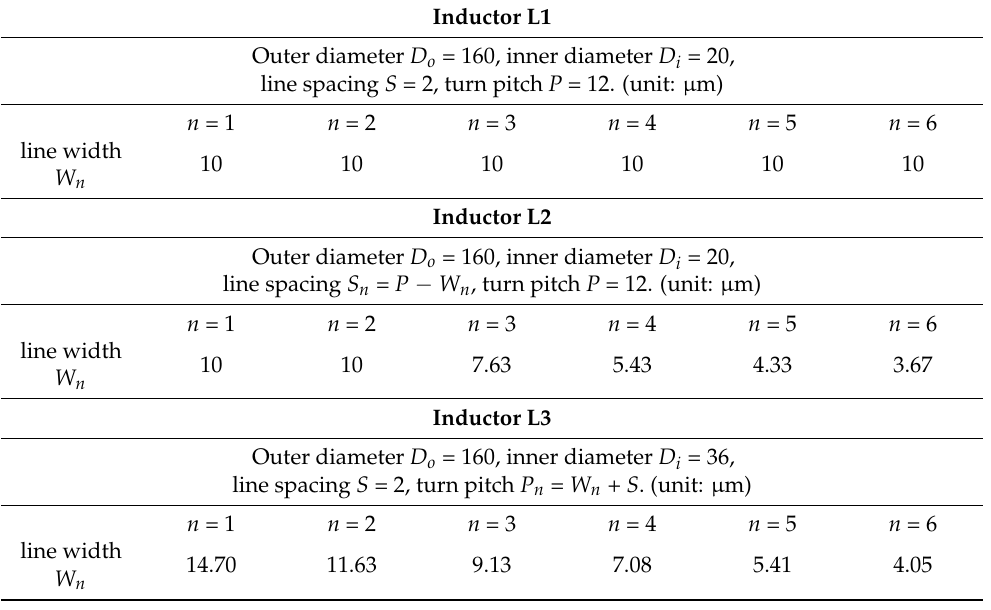
Table 2. Layout parameters of the tested inductors. Inductor L1 Outer diameter D o = 160, inner diameter D i = 20, line spacing S = 2, turn pitch P = 12. (unit: µ m)